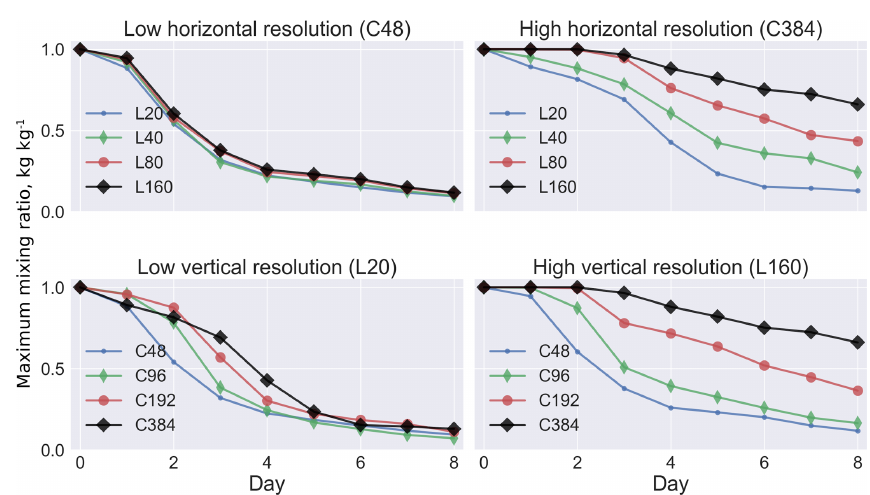
Figure 4. Plume dilution due to numerical diffusion at different model grid resolutions. The plume is released in the free troposphere at northern midlatitudes with an initial mixing ratio of unity. Plume dilution is measured by the decrease in the maximum mixing ratio as a function of time. Model horizontal resolution is defined by a cubed-sphere grid ranging from C48 ( ≈ 200km) to C384 ( ≈ 25km). Vertical resolution is defined by an equally spaced isobaric grid ranging from L20 (20 levels, each 50hPa thick) to L160 (160 levels, each 6hPa